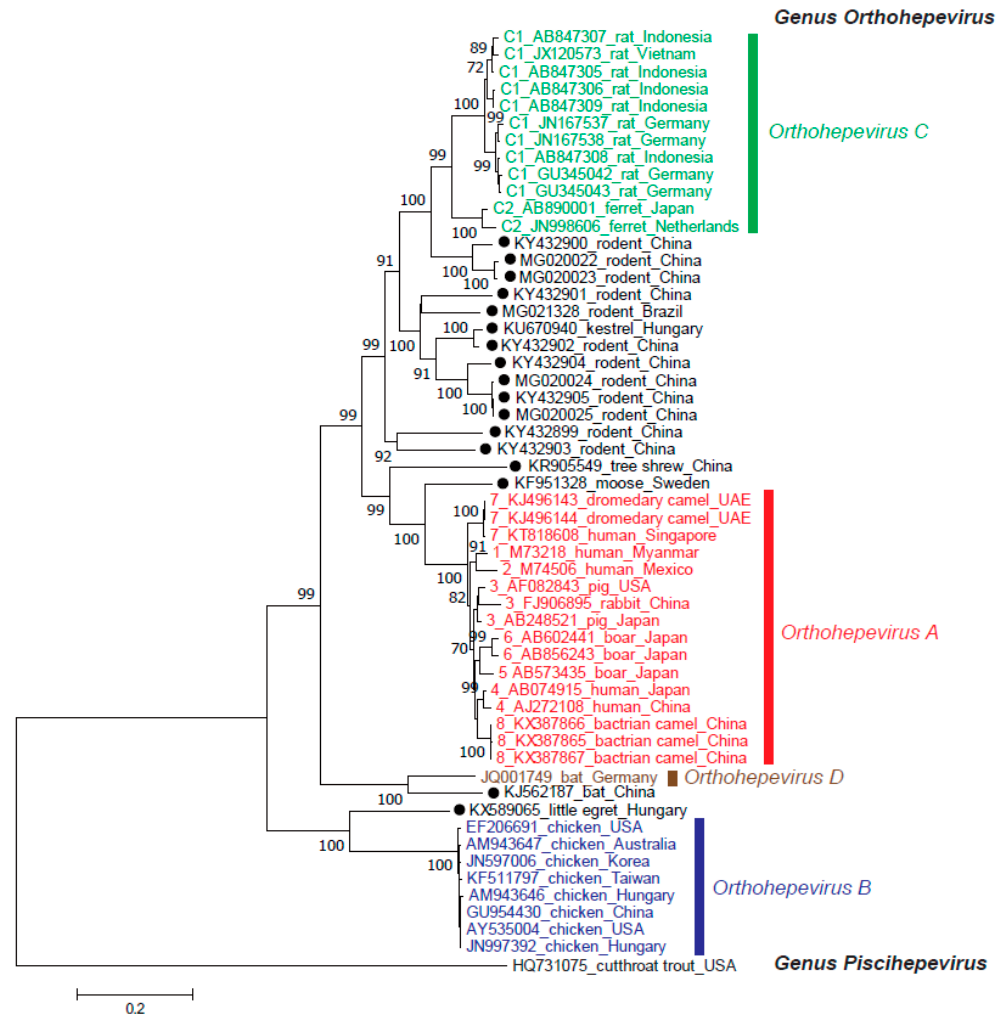
Figure 1. Phylogenetic tree for members of the Hepeviridae family. The maximum-likelihood tree was created using MEGA 7 [24] based on amino acid sequences of the entire ORF2 region from members of the Hepeviridae family. Each reference sequence is shown with the genotype (if available) followed by the accession number, species (animal / human) and the country where it was isolated. Unassigned HEV strains are highlighted with closed circles. The bootstrap values ( > 70%) for the nodes are indicated as percentage data obtained from 1000 resampling analyses. The scale bar indicates the number of nucleotide substitutions per site.